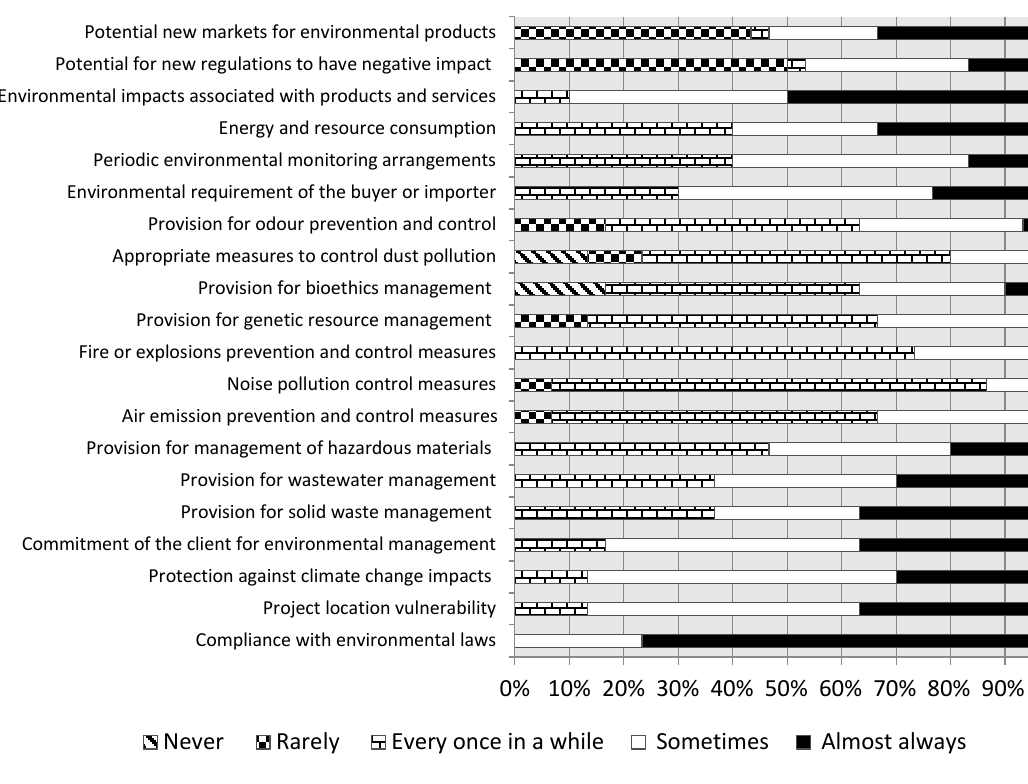
Figure 2. Social issues considered in lending (respondents were allowed to pick multiple choices)